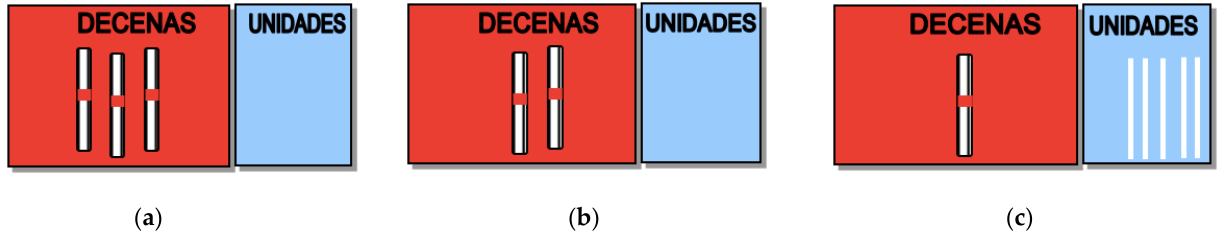
Figure 22. Process to take away 17 from 32: firstly, the student removes 2 units ( a ), secondly, one ten ( b ) and finally 5 units ( c ) by removing a rubber band of one ten. Outside the box they will have ten and seven units and inside ten and five units. The translation to operation will be literal: 32 − 2 − 10 − 5 = 15 Later, when the experience is well internalized, they can resolve based on mental images. Below there are examples of this work. The box provides a great support to under- standing the operations and facilitate the work of translating them into numbers and signs. In Figure 23 we can see how a student graphically creates a static addition proposal, that is, he/she is asked to put together the quantities of two boxes: